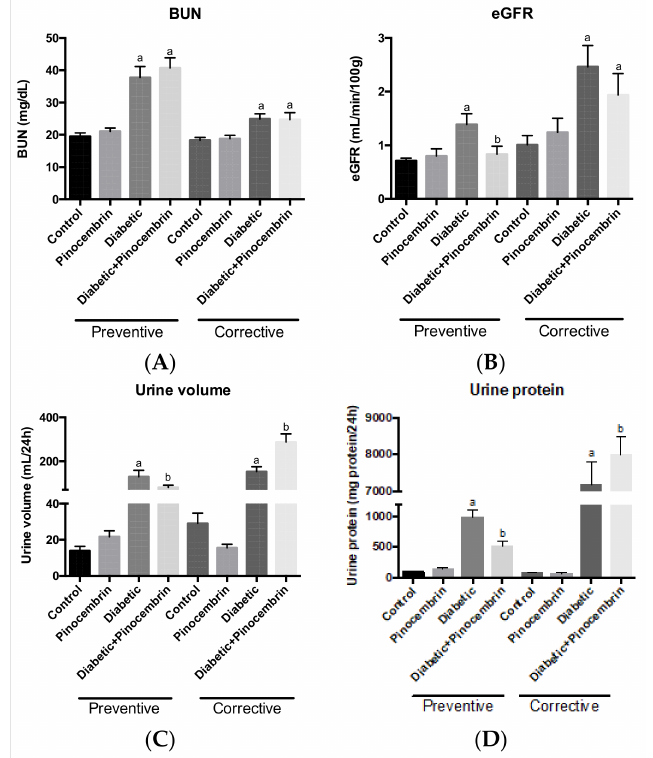
Figure 3. Kidney profile in the schemes of treatment with pinocembrin, 40th day in the preventive scheme and 60th day in the corrective scheme. ( A ) Blood Urea Nitrogen (BUN) levels in the preventive and the corrective schemes; ( B ) Estimated Glomerular Filtration Rate (eGFR) in the preventive and the corrective schemes; ( C ) Urine volume measured in the preventive and the corrective schemes. ( D ) Urine protein levels in the preventive and the corrective schemes. a p < 0.02 vs. Control, b p < 0.002 vs. Diabetic, n =